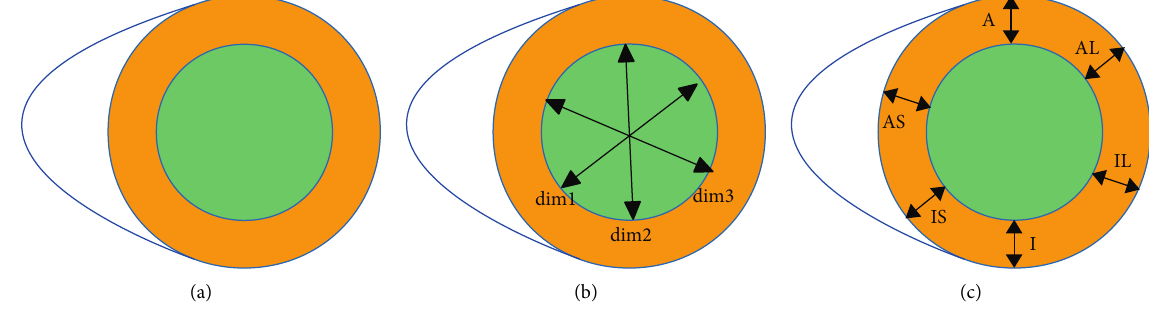
Figure 1: The schematic diagram of evaluated indices [4]. (a) Cavity area and myocardium area in mm 2 . (b) Dimensions of the cavity of three directions (ISAL, IA, and ILAS) in mm. (c) Regional wall thickness in mm, staring from the anteroseptal segment in a counter- clockwise direction (IS, I, IL, AL, A, and AS).